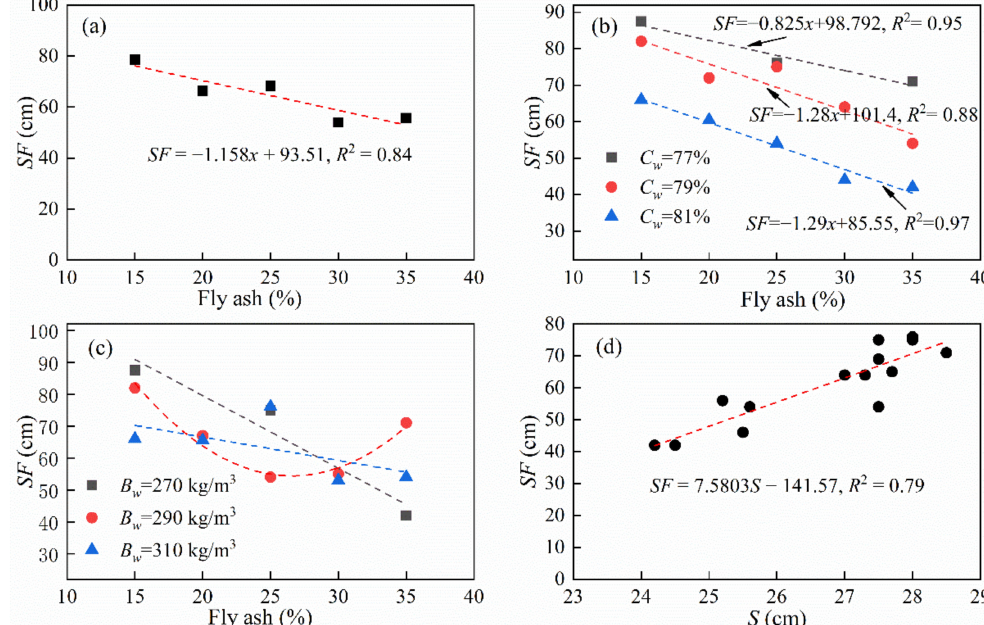
Figure 4. Variation of SF with the fly ash addition at different solid percentages and binder contents: ( a ) average SF vs. fly ash content; ( b ) SF at varying concentrations vs. fly ash content; ( c ) SF at varies binder content vs. fly ash content; ( d ) average SF vs. average S